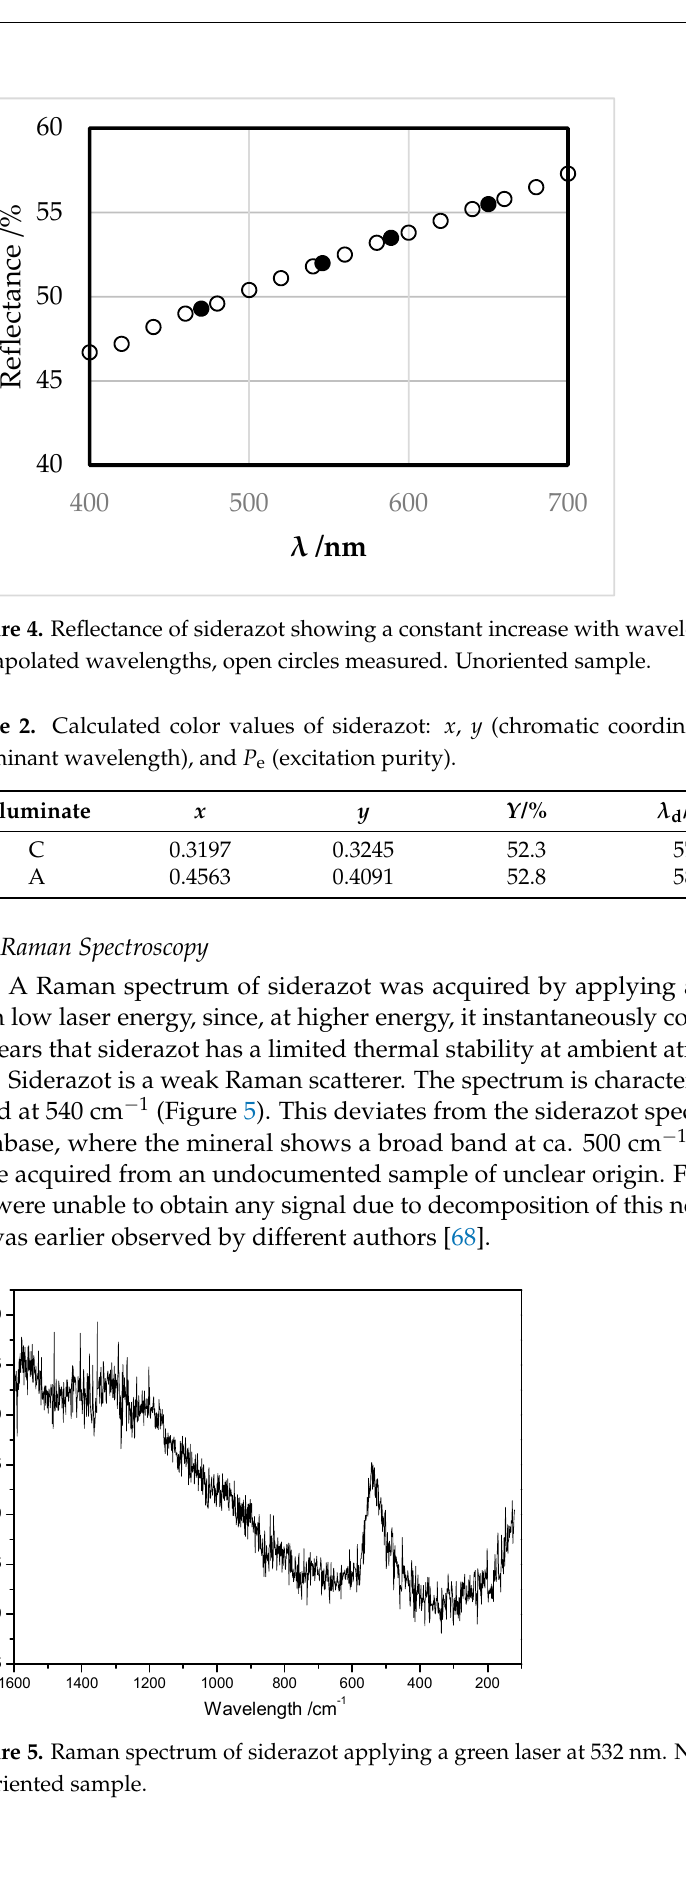
Table 2. Calculated color values of siderazot: x , y (chromatic coordinates), Y (luminance), λ d (dom- inant wavelength), and P e (excitation purity).